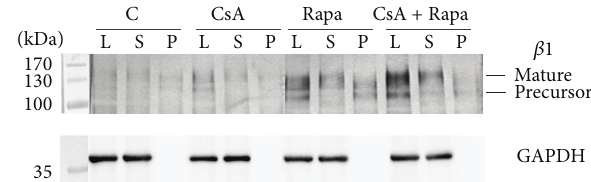
Figure 4: High-mannose/hybrid-type glycans are present mainly on premature 𝛽 1 integrin subunit. Cell lysate (L), glycoproteins precipitated with GNA-agarose (P), and supernatant collected after precipitation (S), containing proteins not recognized by GNA, were resolved on 10% SDS-PAGE gel under reducing conditions, electrotransferredtoaPVDFmembraneanddestinedfor 𝛽 1integrin subunit immunodetection. GAPDH was the endogenous control. C: untreated cells, CsA: cyclosporin A, and Rapa: